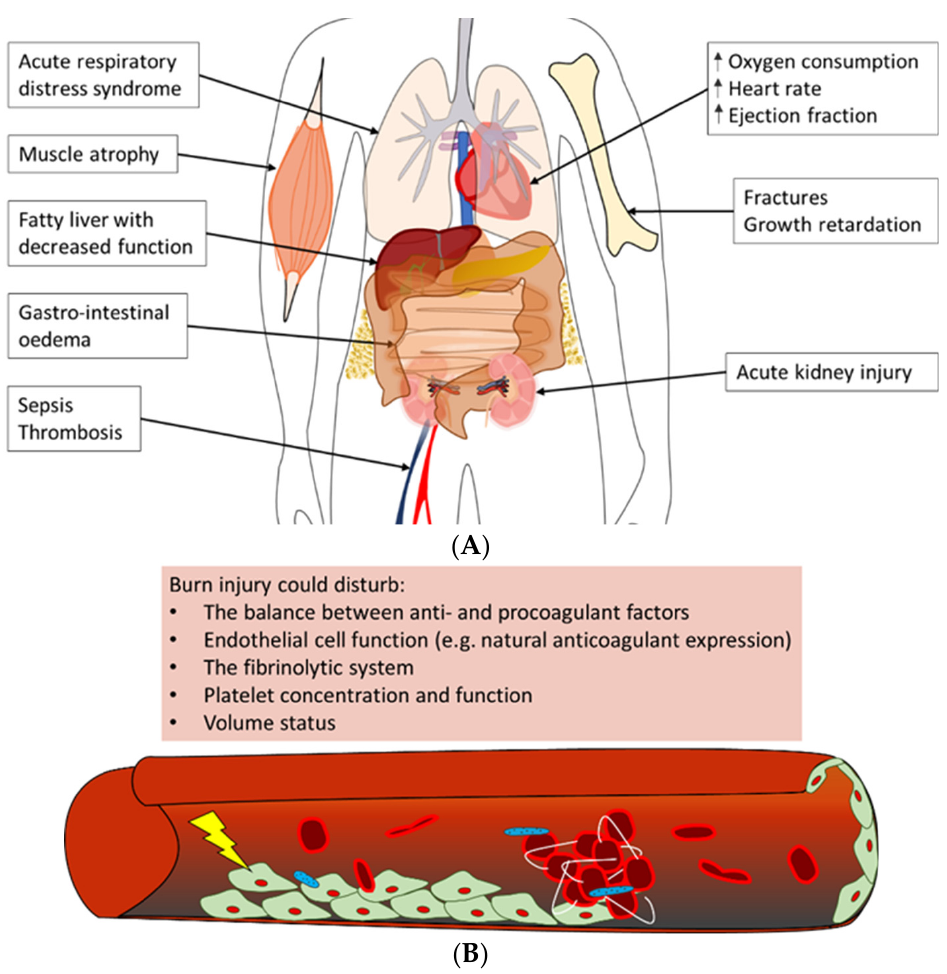
Figure 4. Overview of often observed systemic complications of burn injury [106,121–124]. ( A ) Burn patients could develop a variety of complications post-burn. Summarised are possible adverse outcomes of (severe) burn injury in the acute phase, e.g., acute respiratory distress syndrome and acute kidney injury, as well as long-term negative effects, such as growth retardation and a fatty liver. ( B ) The main trigger of coagulopathy is the inflammatory response post-burn. This response could lead to disturbances in factors that contribute to haemostasis, e.g., pro- and anticoagulant factors, platelet concentration and endothelial cell function, which could result in thrombotic events in burn patients.